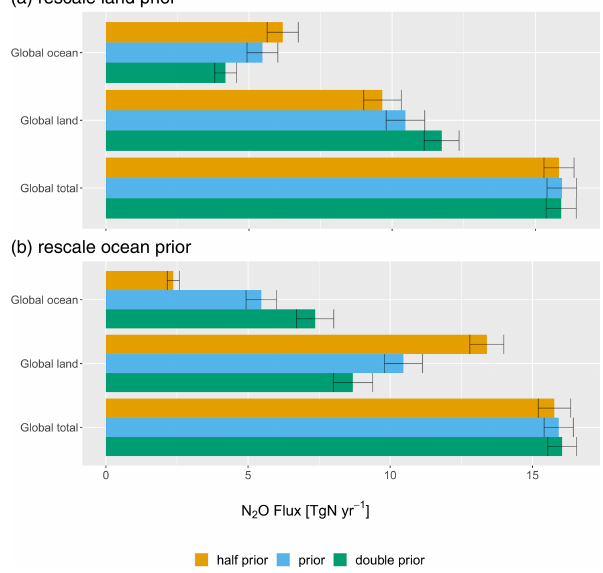
Figure 6. The effect of rescaling the prior emissions over (a) land and (b) ocean on the inferred nitrous oxide flux in the first window of the inversion, inferring fluxes for the year 2011. Orange bars are the inferred fluxes when the prior was halved, blue bars are with the original prior, and green bars when the prior was doubled. The error bars represent the 95% credible intervals on the